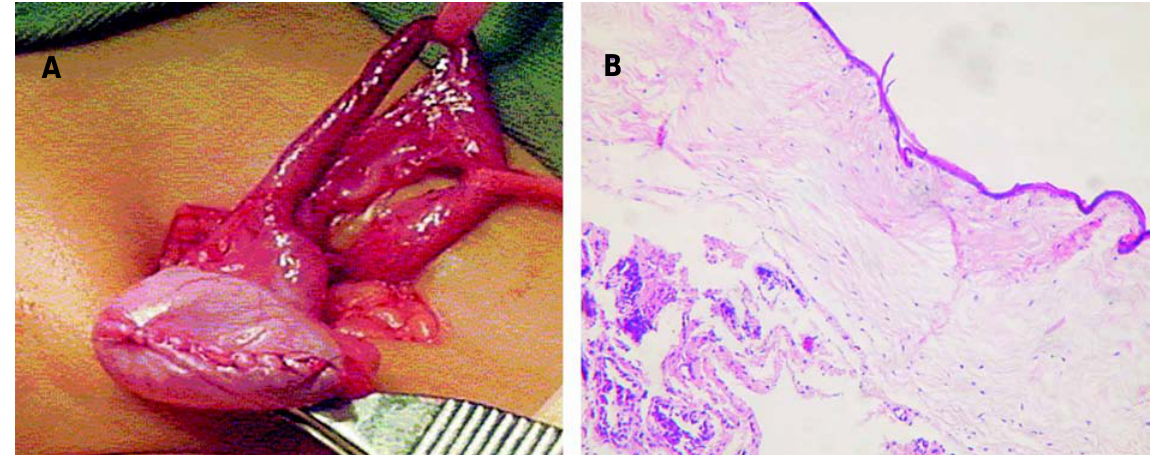
Figure 2 – A) Aspect of gonad following reconstruction. B) Histological examination showing epithelium and support connective tissue of the cyst amidst the testicular parenchyma, compatible with dermoid